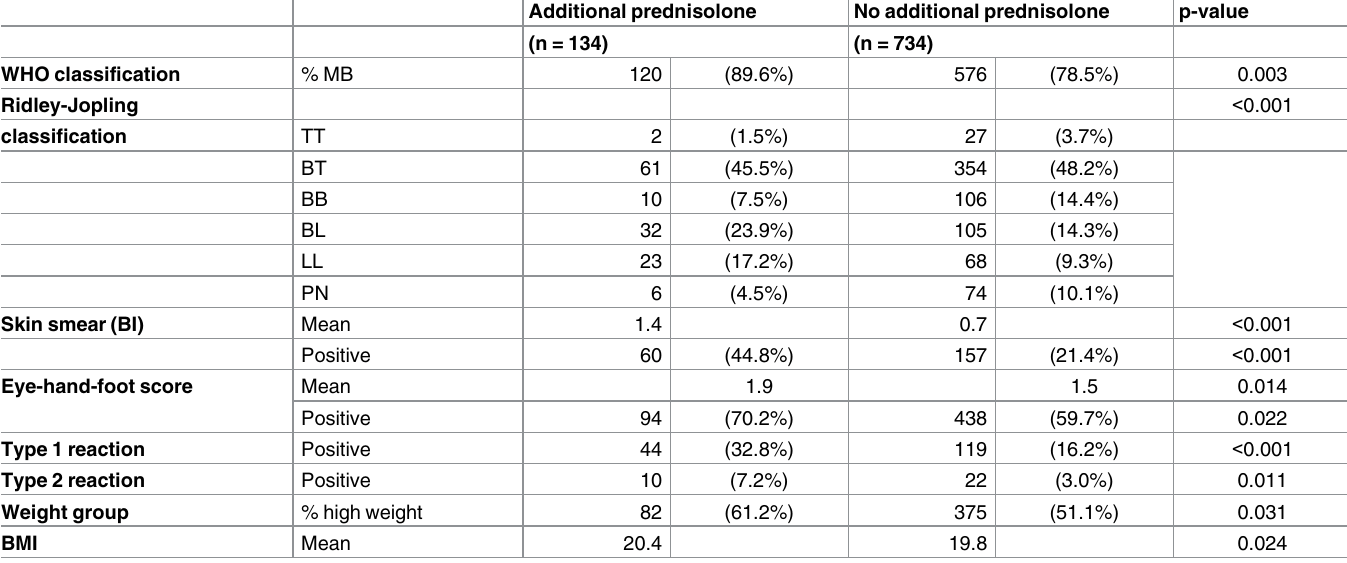
Table 6. Overview of differences in baseline characteristics between the group that needed additional prednisolone and the group that did not need additional prednisolone. Additional prednisolone No additional prednisolone